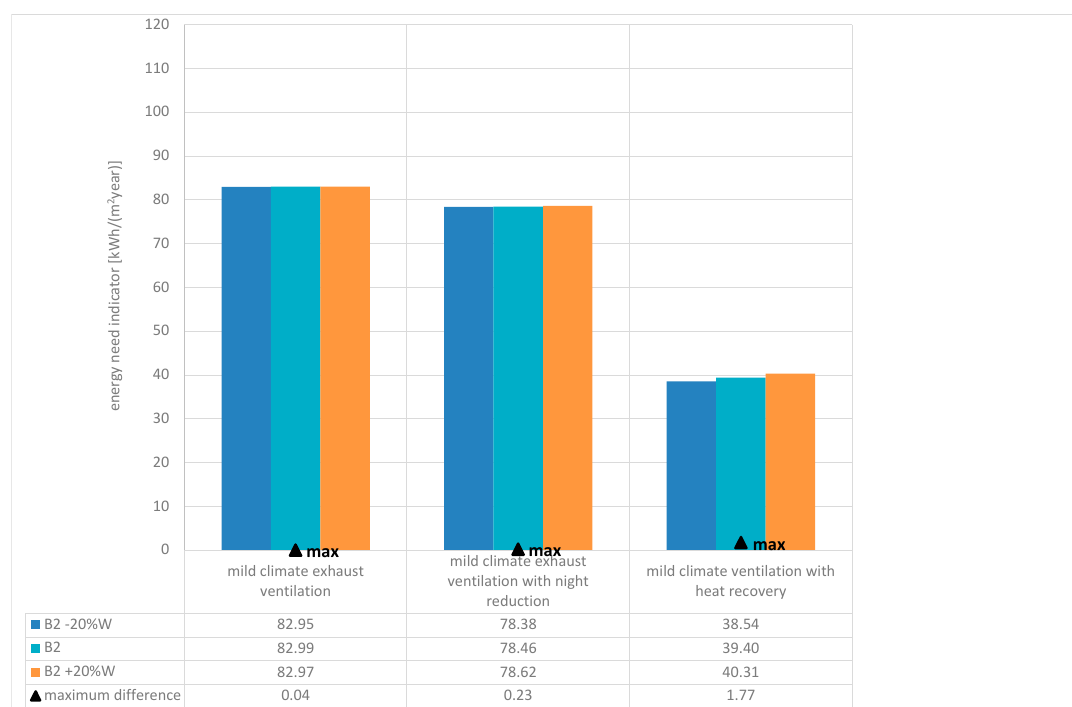
Figure 5. The impact of the window area on the energy need indicator for building B2.